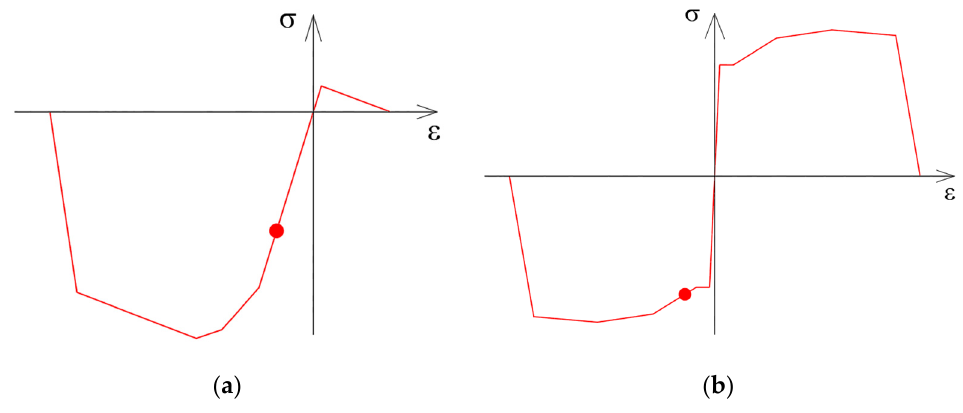
Figure 2. Stress-strain curve of material: ( a ) concrete; ( b ) steel.